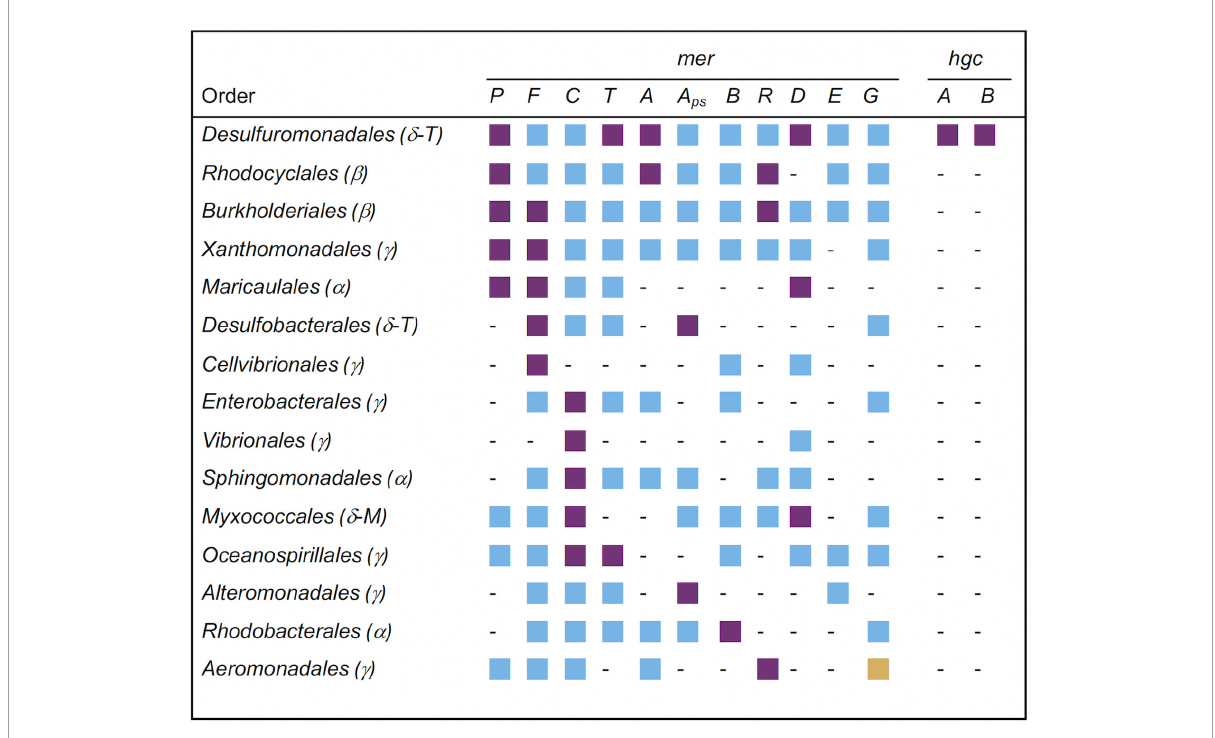
FIGURE4 Significantly overrepresented orders of the phylum Proteobacteria (syn. Pseudomonadota ; subphyla: Alpha( α )-, Beta( β )-, Gamma( γ )-, Delta( δ )proteobacteria ) carrying mer - and hgc -genes in soil with the highest Hg contamination level. Deltaproteobacteria are currently placed in the novel phylum-level lineages Thermodesulfobacteriota ( T ) and Myxococcota ( M ) (Oren and Garrity, 2021). Mer and hgc genes correspond to those listed in Table 2 . A ps : merA _primer specific: Alignment against nucleotide sequences containing primer-binding site (see Material & Methods). Purple squares: significantly overrepresented ( P < 0.05); blue squares: not significantly overrepresented ( P ≥ 0.05); yellow squares: significantly underrepresented ( P < 0.05); -: not